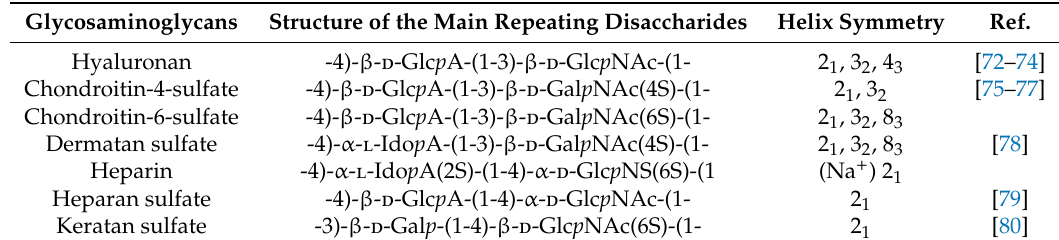
Table 2. Characterization of the helix symmetry of GAGs polysaccharides in the solid-state.